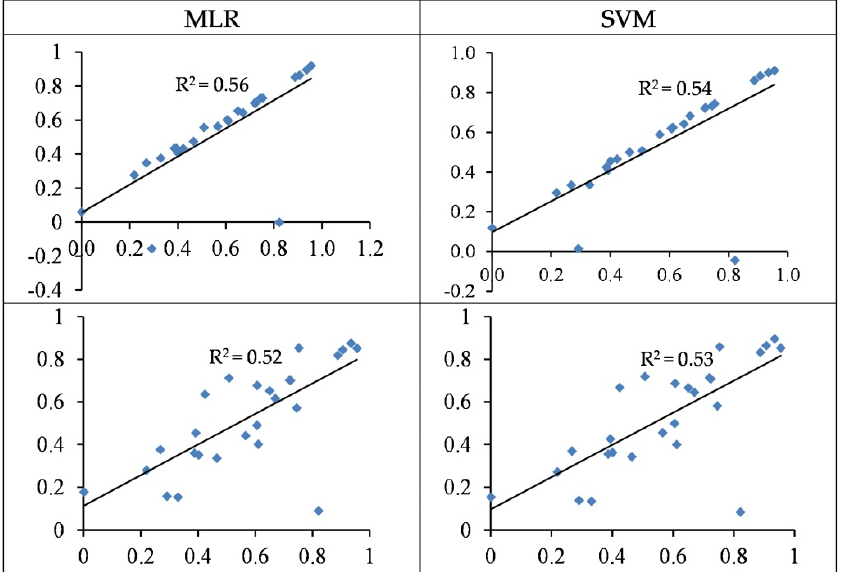
Figure 5. Standardized values (between 0 and 1) of the observed (horizontal axis) and the predicted (vertical axis) concentration of Cu based on wavelengths (top) and spectral indices (bottom) in the testing sets of the SVM and MLR methods.